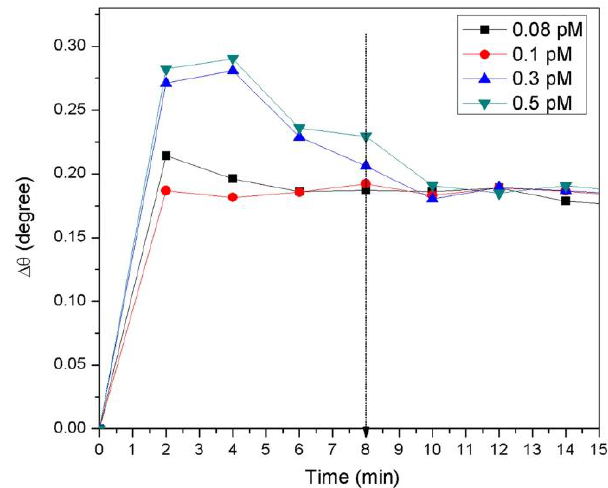
Figure 4. Realtime detection for different concentrations of DENV-2 E-proteins in contact with Au/DSU/NH 2 rGO-PAMAM/IgM sensor film. Reused with permission from Springer Nature [88].